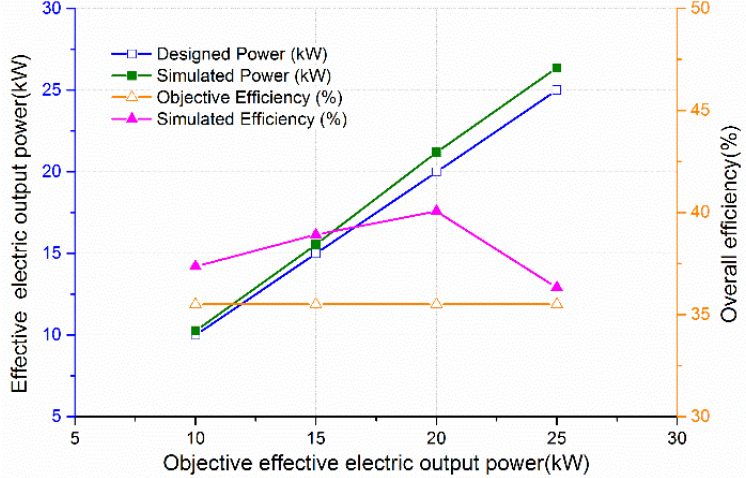
Figure 16. Power and efficiency comparison for various power demands.